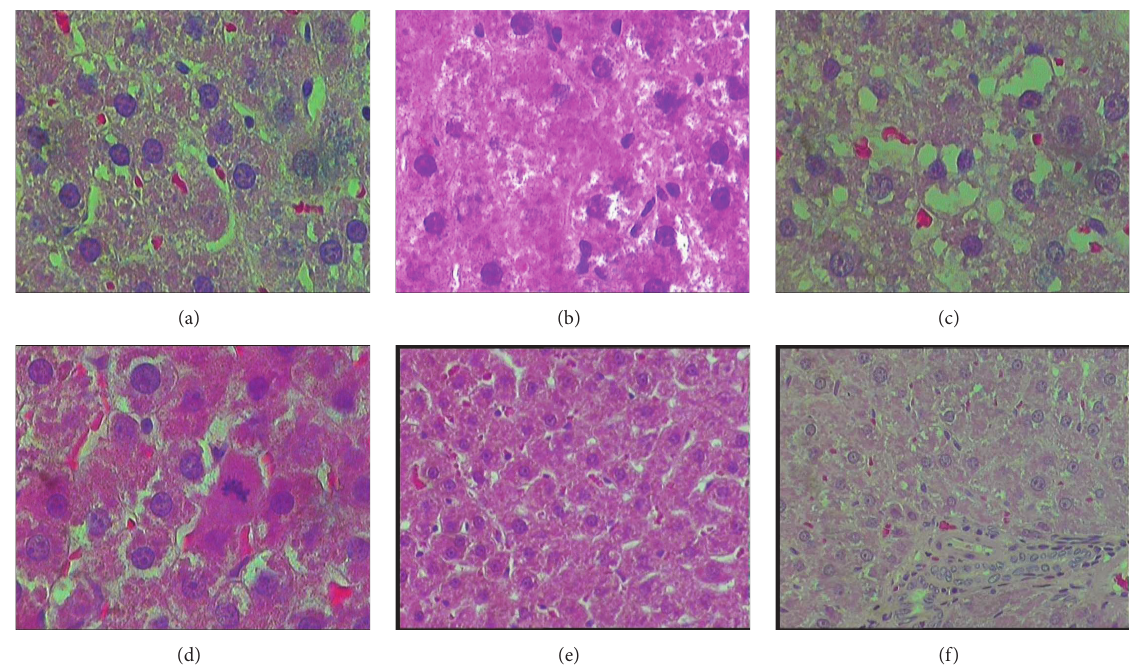
Figure 3: Representative histopathology slides ( × 20) of rat livers from control (untreated) and PAR treated rats and their respective pathology reports. (a) (No PAR): section of rat liver from the untreated group: “ No pathology appears to be present in the control (untreated) animals ”; (b) (PAR × 2 days): PAR for 2 days. “ moderate granular vacuolar degeneration and cell swelling, and minimal cytonecrosis, loss of cell boundaries, minimal mitosis, and minimal centrilobular zonal necrosis ”. (c) (PAR × 7 days): PAR for 7 days: “ mild degeneration and minimal cytonecrosis ”. (d)(PAR × 14days):PARfor14days.“ moderategranularvacuolardegenerationandcellswelling,andminimalcytonecrosislossofcellboundaries, minimal mitosis, and minimal hepatocyte mitosis ”. (e) (PAR × 28 days): PAR for 28 days: “ Hepatic cords with minimal vacuolar degenerative changes ( × 20) ”; (f) (PAR × 42 days): PAR for 42 days: “ Periportal hepatocytes, minimal degeneration visible ( × 20) ”.